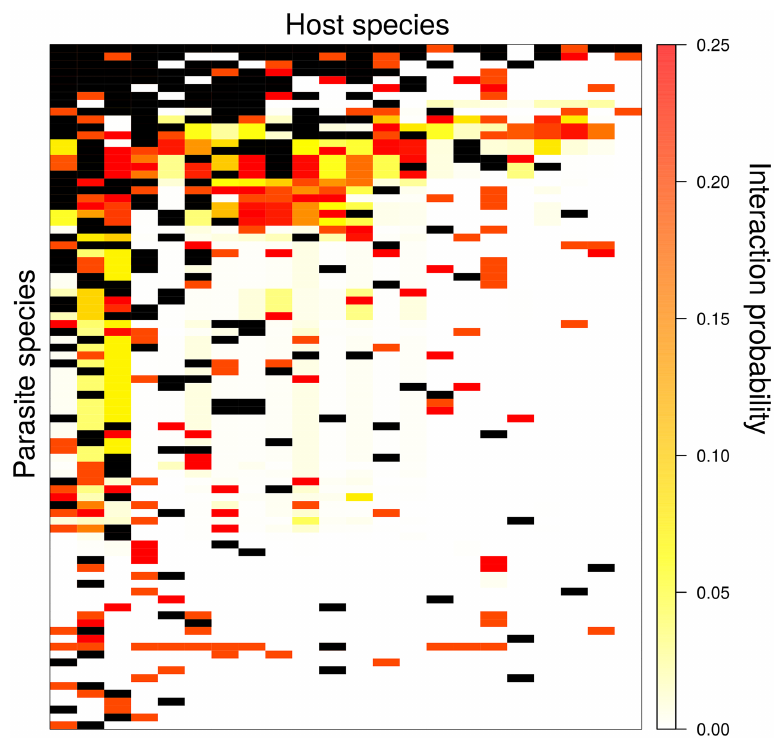
Fig 2. The Sevilleta interaction matrix, where rows correspond to parasite species, and columns to rodent host species. Black boxes indicate an interaction betweenhost and parasite, and color indicateslog transformed interaction suitabilityas determined by the plug-and-play algorithm. Larger suitability values indicatea higherpredictedlikelihoodof an interactionbetweena host (column) and parasite(row) species.